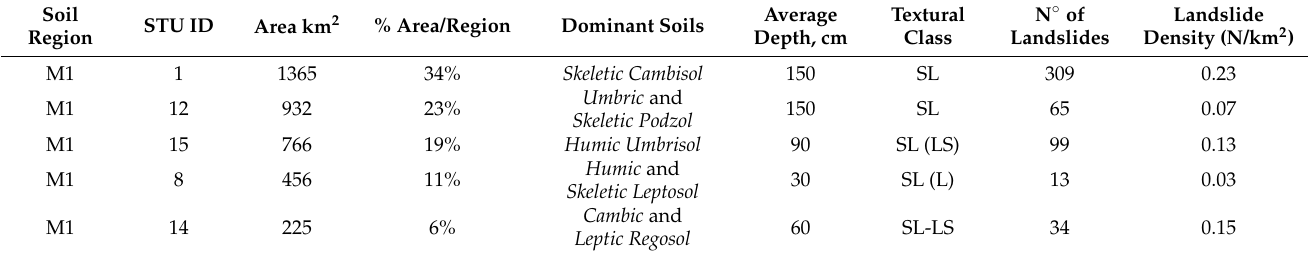
Table 1. Extension (in km 2 and as a percentage), classification of the dominant soil(s), average depth of the soil profile and its textural class(es), number of recorded landslides, and landslide density for each soil typological unit (STU) identified within the soil regions M1 and M2 of the Alps and Prealps of Lombardy. SL: Sandy Loam; LS: Loamy Sand; L: Loamy; CL: Clay-loam; SiL: Silt Loam; SCL: Silty Clay